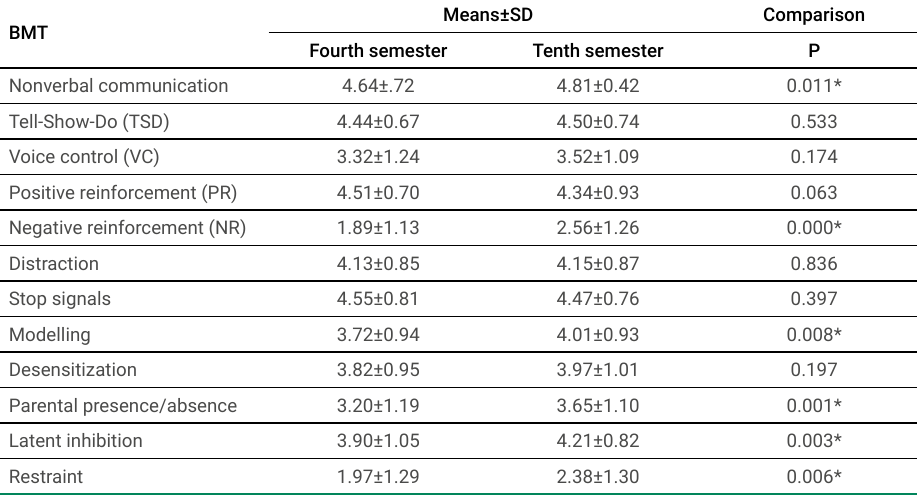
Table 1. Means and standard deviations of the acceptability scores and comparisons between students` rates from the pre-clinical and clinical students Means±SD Comparison BMT Fourth semester Tenth semester P